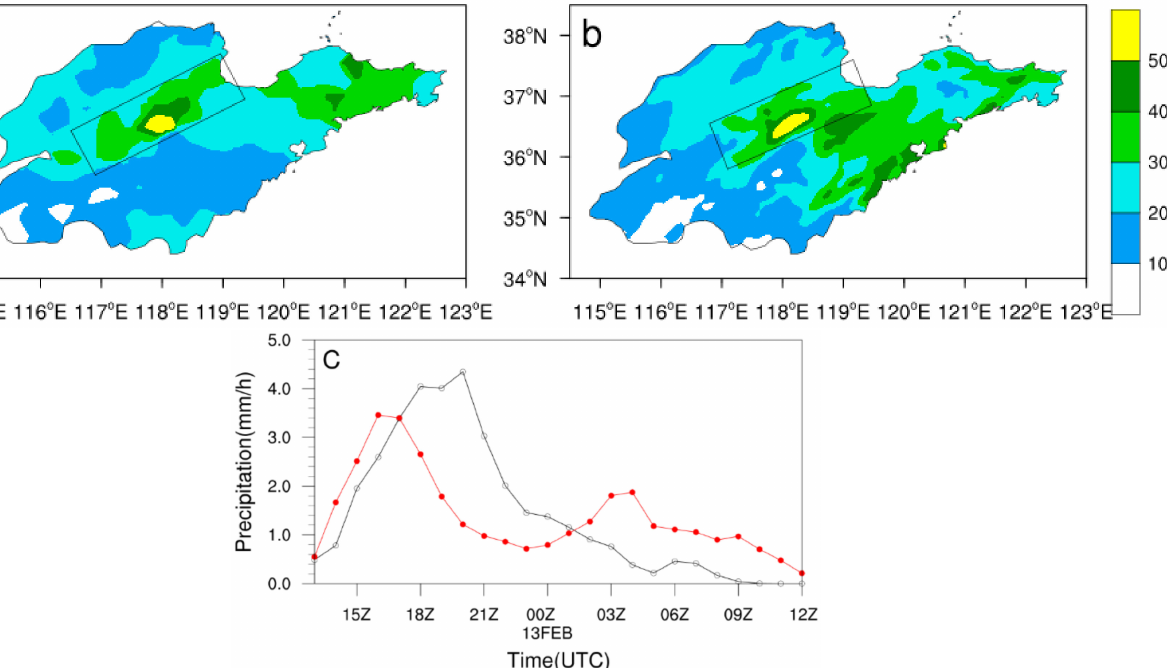
Figure 6. Distribution of the 24 h accumulated precipitation (unit: mm) during the period 1200 UTC on 12 to 1200 UTC on 13 February 2016 derived from ( a ) rain gauge observations and ( b ) the model simulation from the 4 km domain. The black rectangular box denotes the control region. ( c ) Time series of the hourly precipitation (unit: mm · h − 1 ), averaged over the rectangular box during the period from 1200UTC on 12 to 1200 UTC on 13 February 2016 between the observations (black line) and the 4 km domain simulation (red